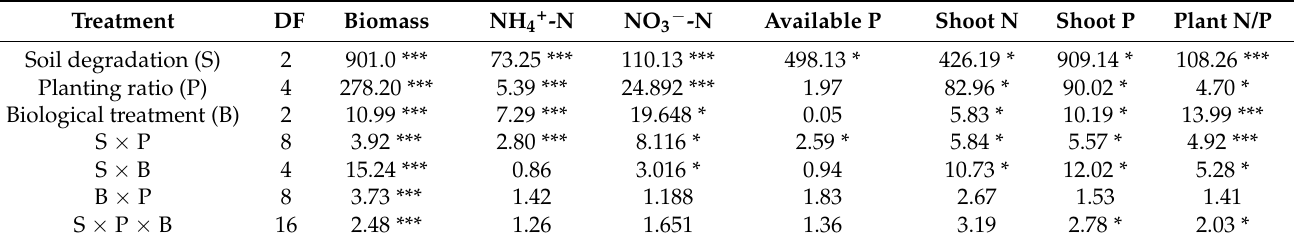
Table 2. Analysis of variance of the effects of soil degradation degree (S), planting ratio (P), and soil biological treatment (B) on plant and soil indicators.